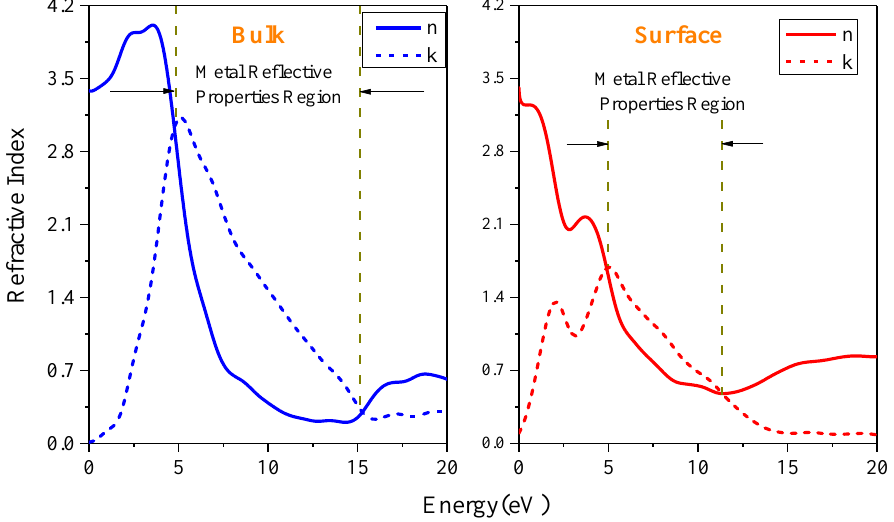
Figure 7. Complex refractive index of the In 0.87 Ga 0.13 As 0.25 P 0.75 bulk and surface.